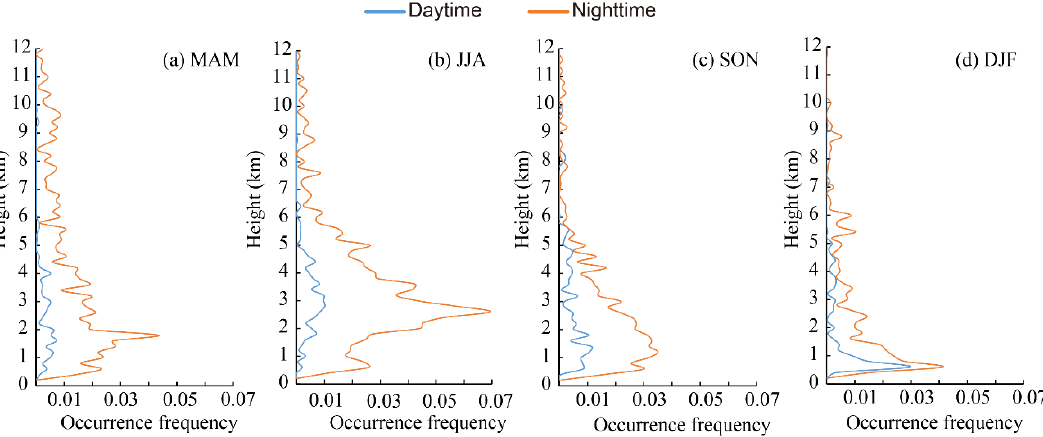
Figure 7. Vertical distribution of occurrence frequencies of polluted continental/smoke layer in the daytime and nighttime in the Aral Sea region from CALIPSO observations for four seasons. The vertical distribution of the occurrence frequency of the clean continental layer is presented in Figure 8, showing significant seasonal and diurnal variations. Clean conti- nental was more frequently observed in the nighttime and seldom detected in the daytime due to the thin-layer features and low occurrence frequency [80]. Therefore, observations during the nighttime are the focus of this section. In spring, clean continental was